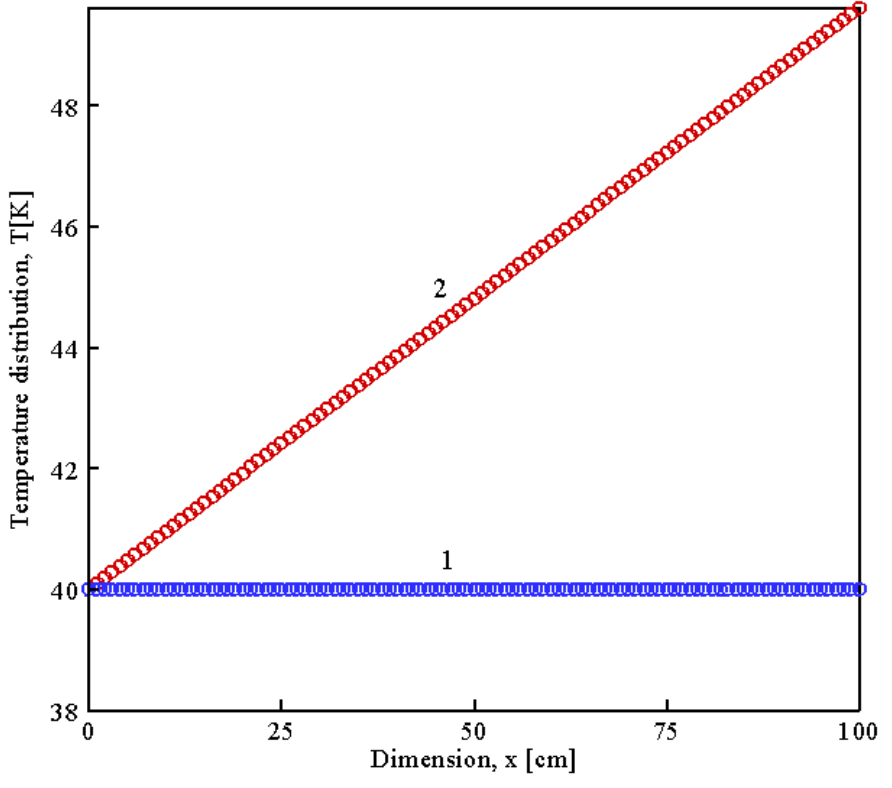
x ; curve 1 represents the thermal dis-